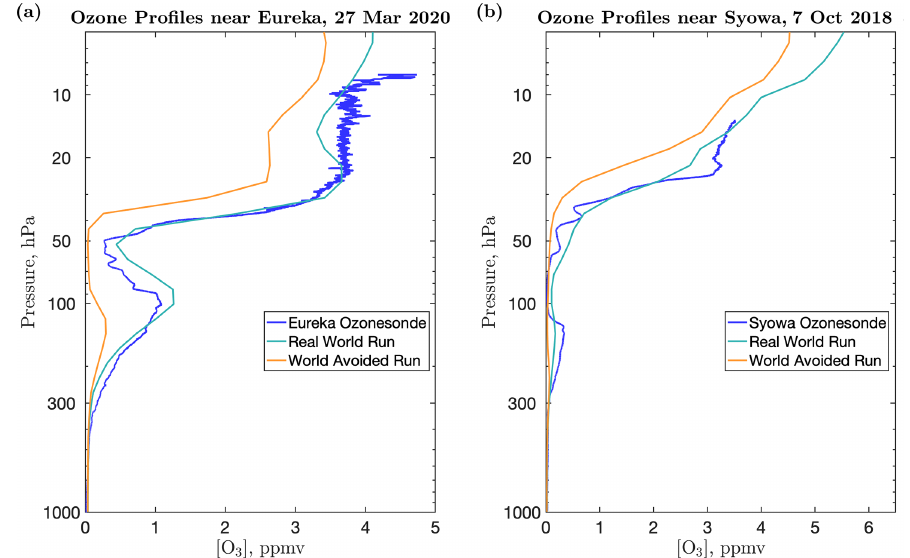
Figure 6. Comparison between the RW (teal) and WA (orange) ozone profiles in SD-WACCM at the grid point (a) nearest to Eureka Station (80.04 ◦ N, − 86.18 ◦ E) for 27 March 2020 and (b) nearest to Syowa Station in the Antarctic (69.00 ◦ S, 39.58 ◦ E) for 7 October 2018. Ozonesonde profiles from the stations are shown, for comparison, in blue.